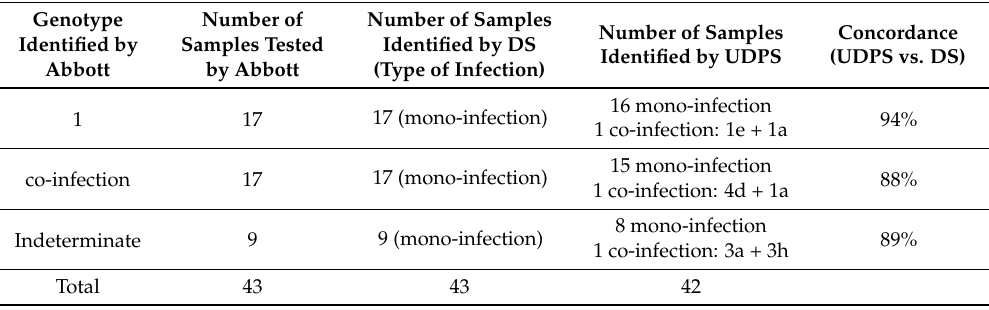
Table 2. Concordance between direct sequencing (DS) and ultra-deep pyrosequencing (UDPS) in the HCV genotype analysis.